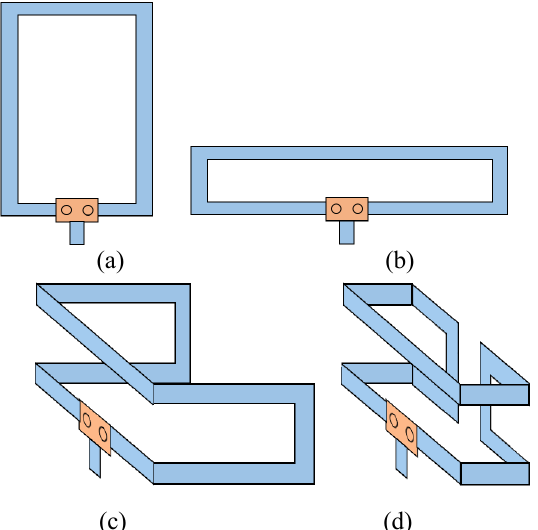
Figure 4: Steps toward the final design target of the proposed RFSR: (a) Step 1, (b) Step 2, (c) Step 3, and (d) Step 4.